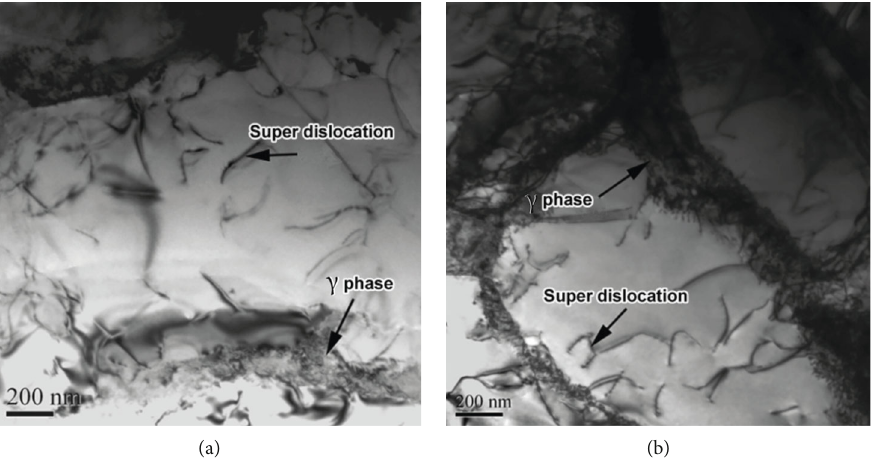
Figure 7: Dislocation con fi guration of the single crystal alloy with di ff erent orientations after creep rupture at 850 ° C/450 MPa: (a) [001] orientation; (b) [111]